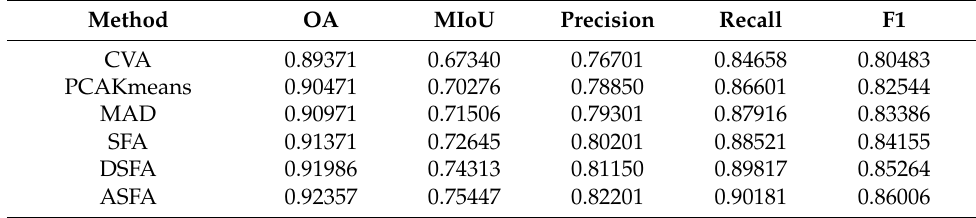
Table 13. The comparative experiment results on LEVIR-CD.